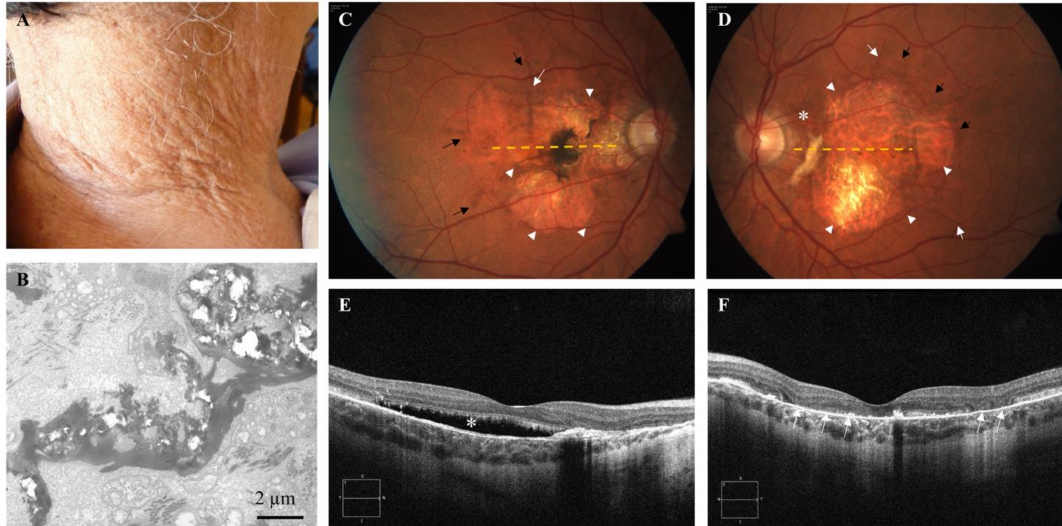
Figure 1. ( A ) Skin plaques in the neck area. ( B ) Mineral precipitates deforming, and cracking dermal elastic fibers are observed by transmission electron microscopy ultrastructural analysis. ( C , D ) Color fundus photographs of the posterior pole of the right and left eye show angioid streaks (white arrows), and macular atrophy (arrowheads) with a juxtafoveal pigmented scar in the right eye ( C ) and fibrotic tissue at the interpapillomacular region in the left eye ( D ) (asterisk). Pattern dystrophy-like changes (pigment deposition) were evident at the posterior pole (black arrows); orange dashed lines show OCT scan position. ( E , F ) Optical coherence tomography (OCT) examinations show subretinal fluid (asterisk) at the fovea in the right eye ( E ) and widespread RPE atrophy with atrophy of the outer retinal layers (arrows) in the left eye ( F